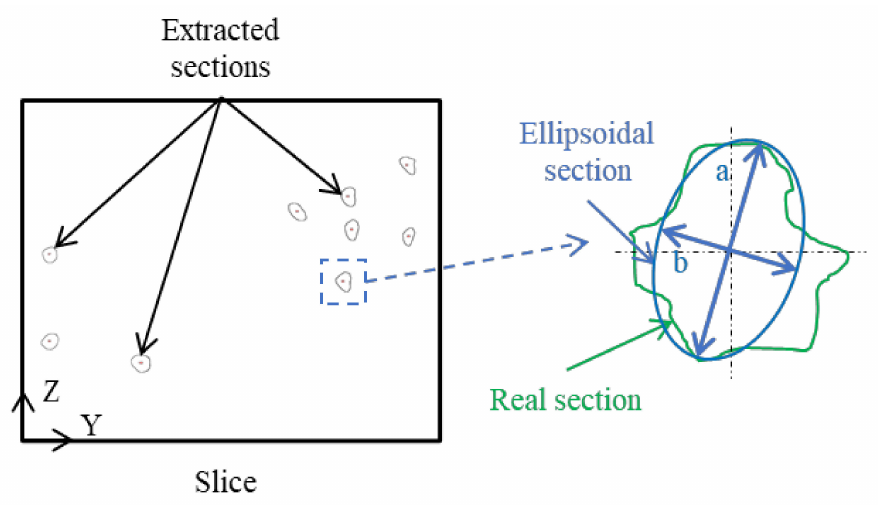
Figure 9. Principle of the statistical analysis of the eccentricity of